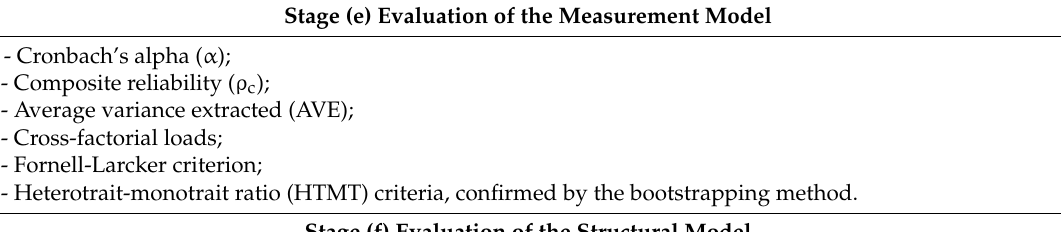
Table 5. Systematic evaluation of PANAS-GAD-7-IDATE results. Stage (e) Evaluation of the Measurement